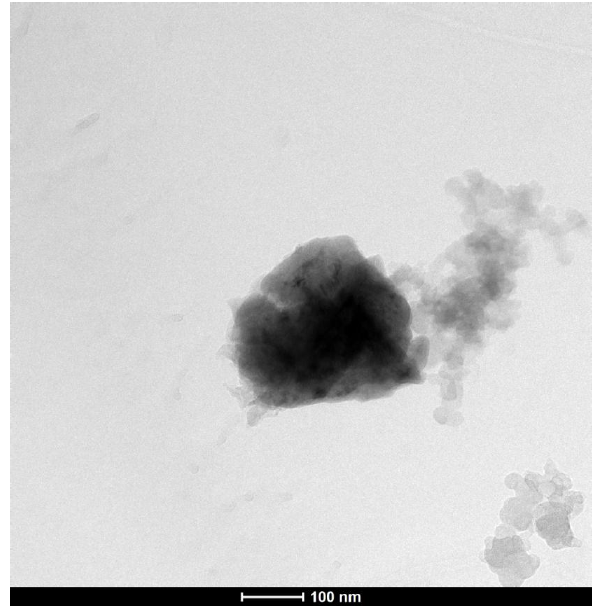
Figure 14. TEM image of an O-, S-, Fe-, and Mg-containing parti- cle aggregation sampled using a PVC pipe in a fault above a con- cealed ore body of the Dongshengmiao deposit.